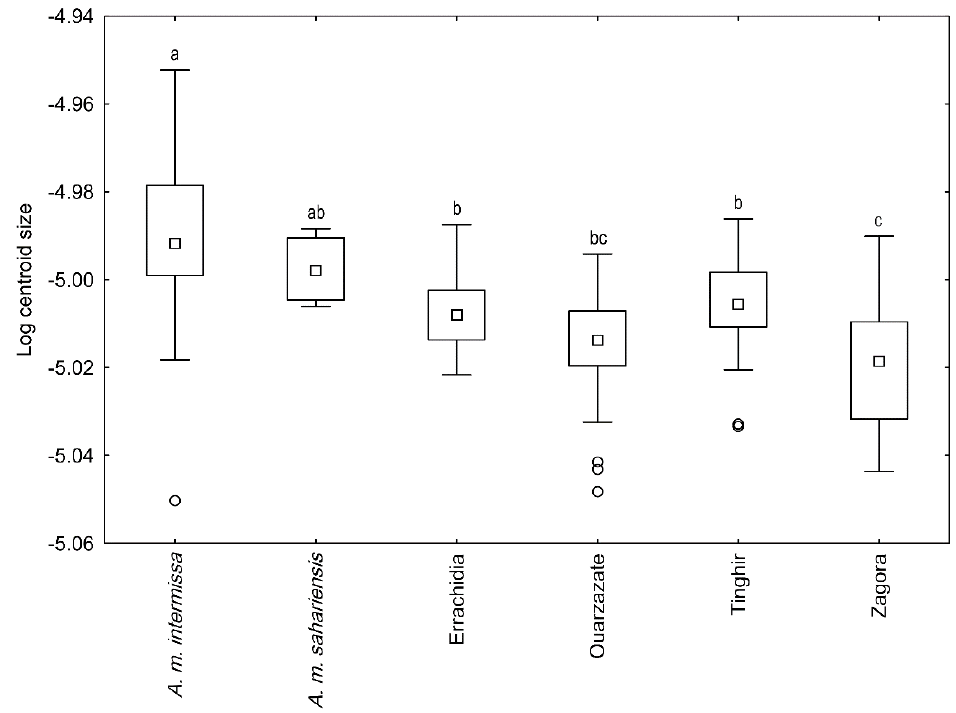
Figure 5. Differences in wing size between honey bees from four areas of south-eastern Morocco and reference samples of A. m. sahariensis and A. m. intermissa . Boxes indicate 25th and 75th percen-tiles; whiskers indicate the range; square markers indicate medians and circles indicate outliers. The same letters above whiskers indicate no significant difference.